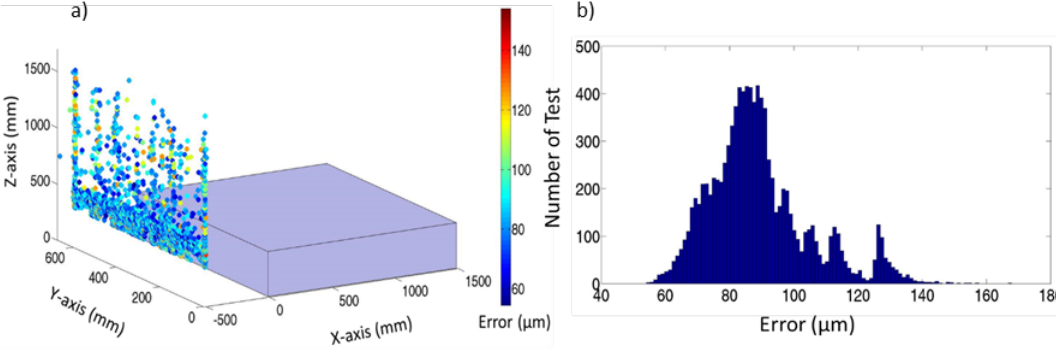
Figure 7. ( a ) Error and LT location area in the narrow zone using an LT. ( b ) Histogram of residual error.